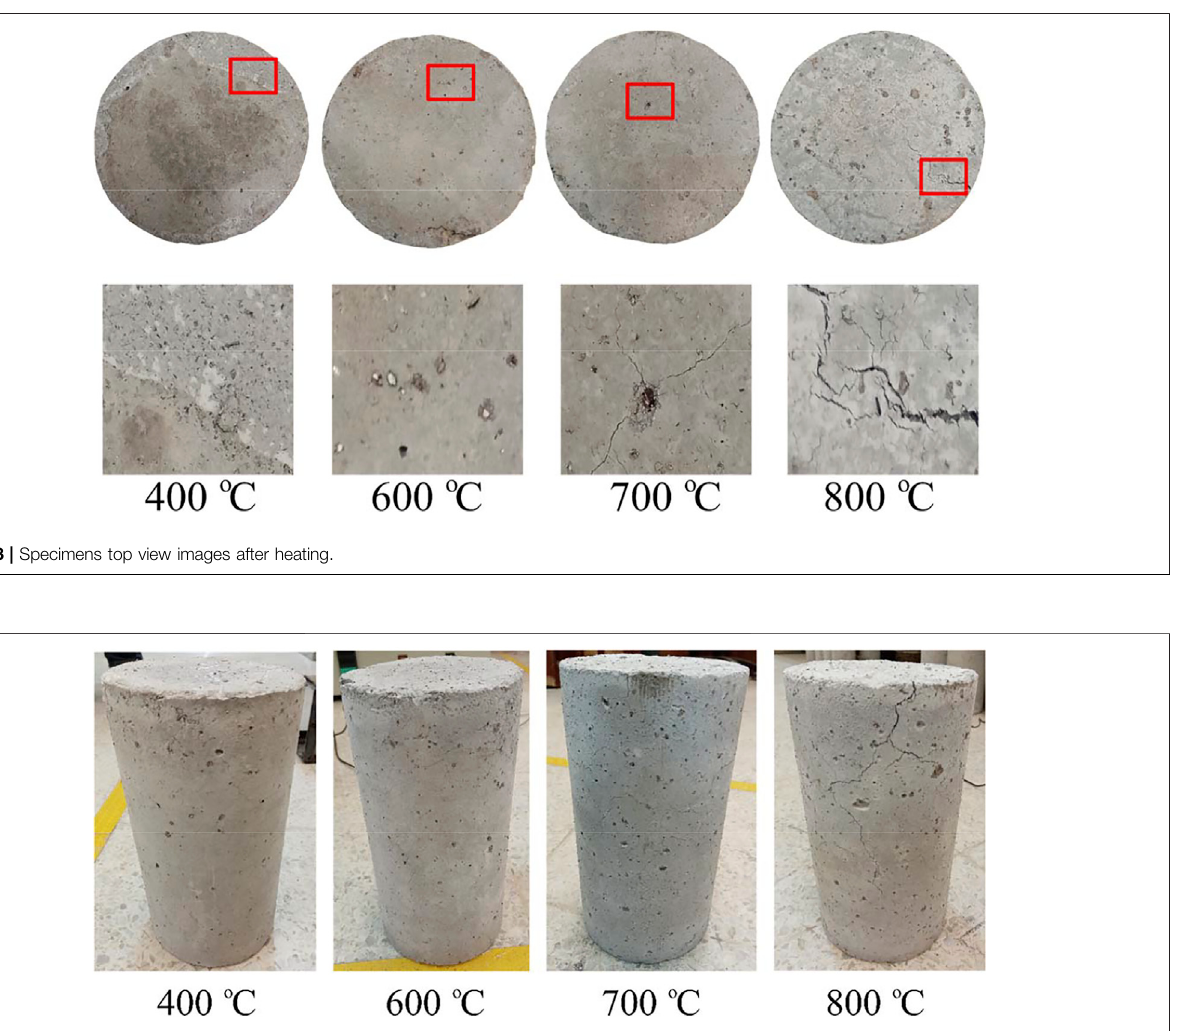
FIGURE 4 | Specimens side view images after heating.